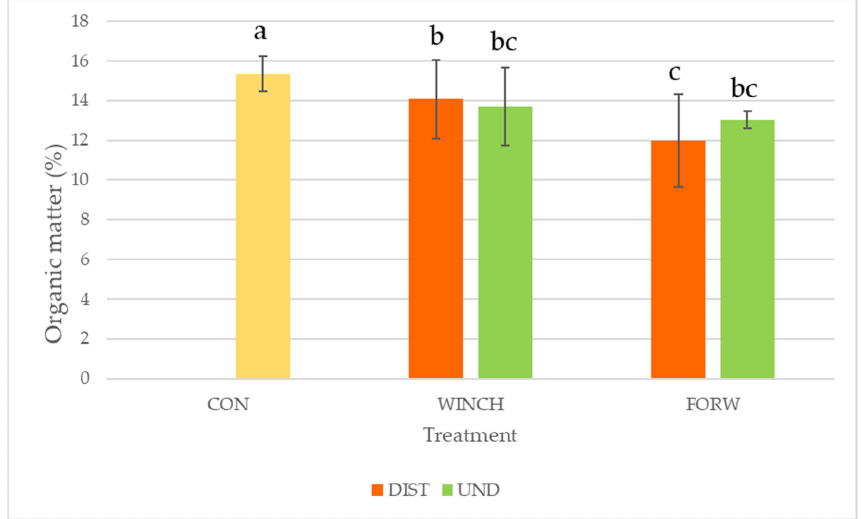
Figure 5. OM for the different treatments. Different letters indicate different homogeneous groups according to an HSD Tukey test ( p < 0.05): CON: control area; WINCH: winching; FORW: forward-